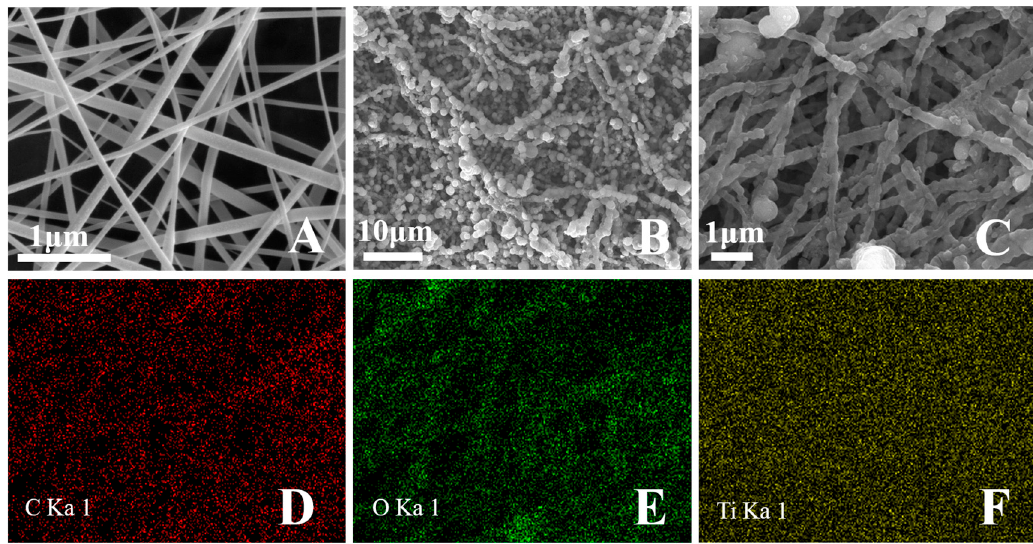
Figure 1. Scanning electron microscopy (SEM) images of: ( A ) electrospun PAN nanofibers; ( B ) PAN@TiO 2 nanofibers at low magnification; and ( C ) PAN@TiO 2 nanofibers at high magnification.